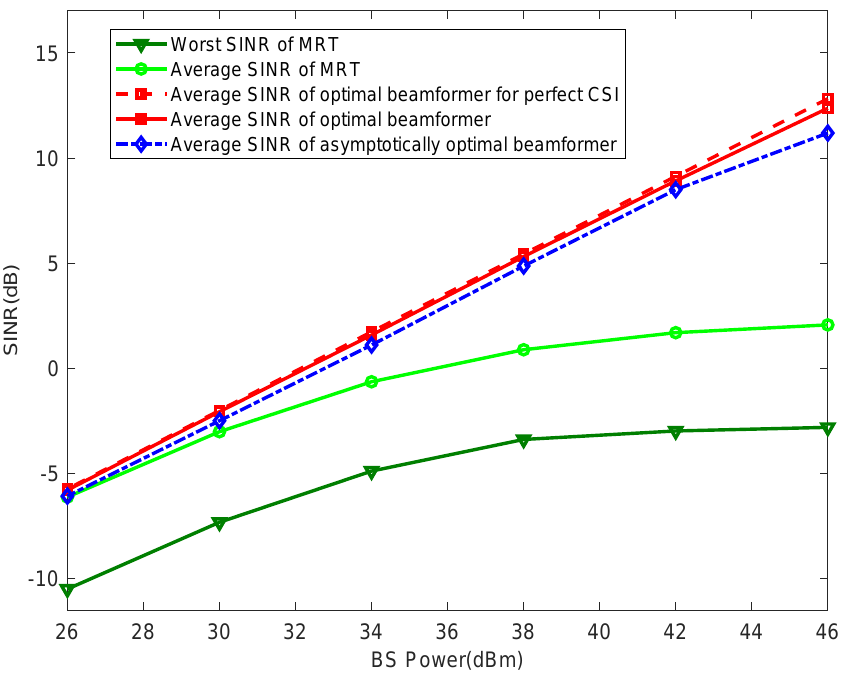
Figure 5. The achieved SINR among several algorithms with regard to P ( M = 64, I = 4, K = 3, r = 0.7, τ = 0.1).